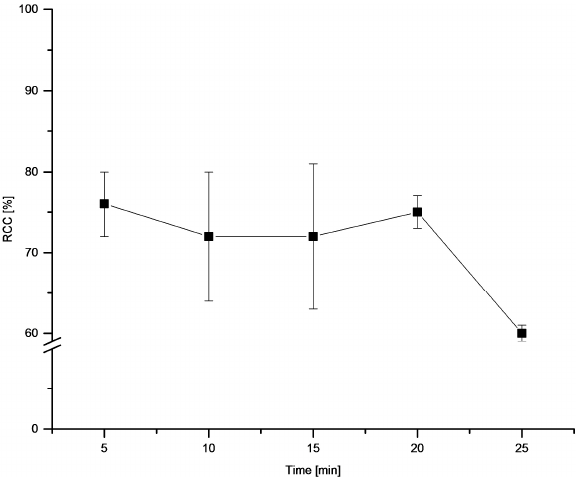
Figure 8. Dependency of RCC on reaction time. Conditions: [ 18 F]Fluoride (~50 MBq) was eluted from a QMA-CO 3 cartridge with a solution of Et 4 NOTf (3.1 mg, 11 µmol) in n BuOH (300 µL) (see legend of